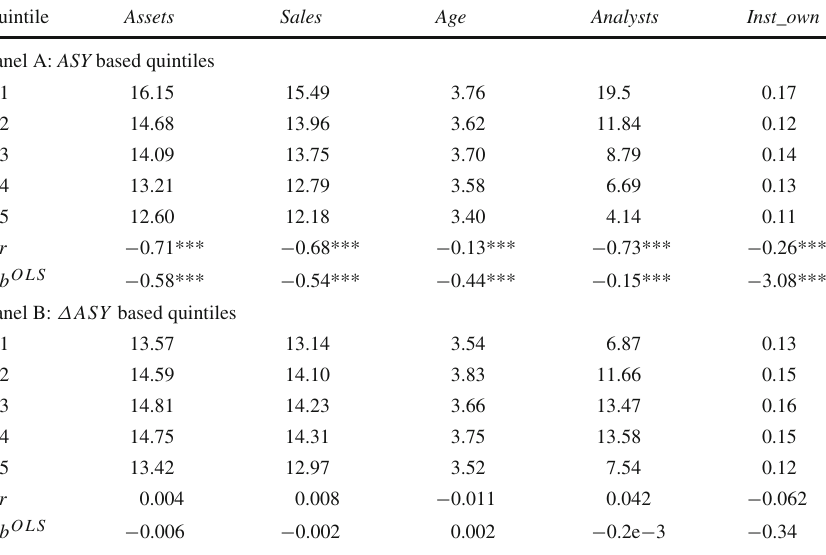
Table 2 Accounting and firm environment variables across adverse selection